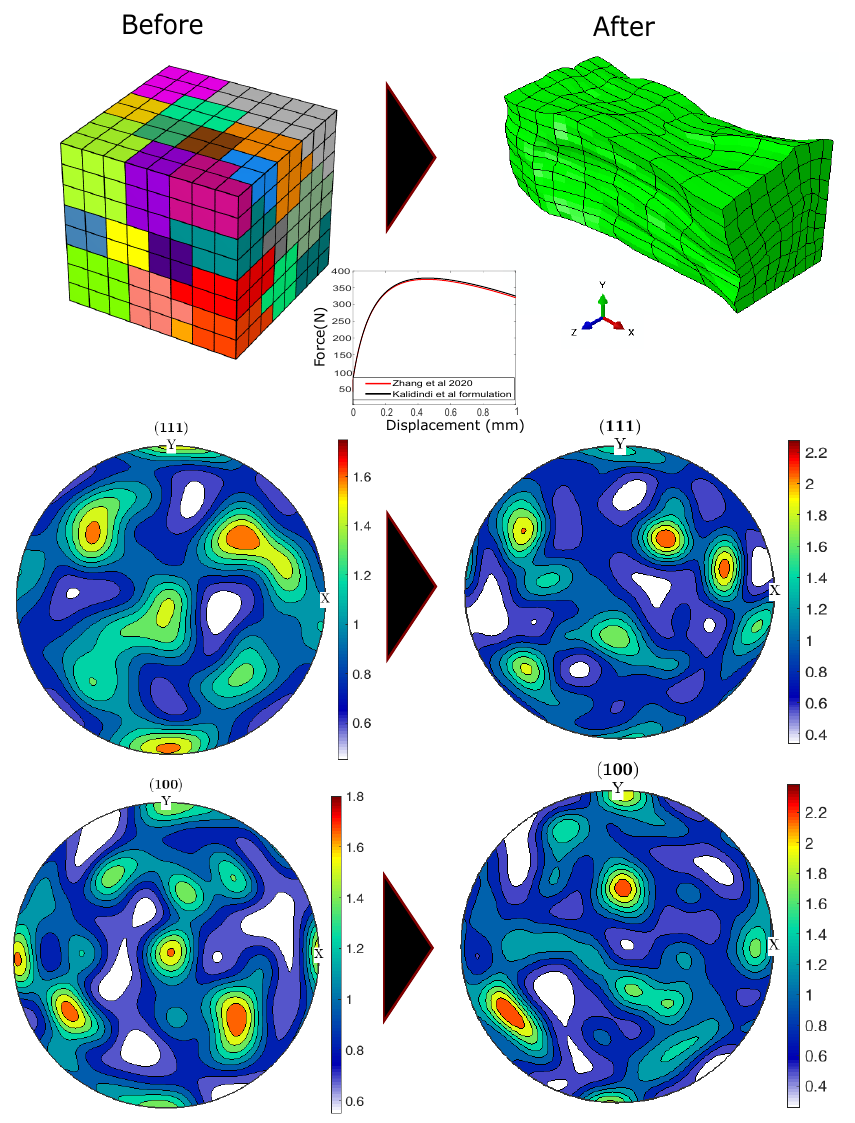
Figure 9. Evolution of texture in copper under a tensile test. Upper row contains the initial and final mesh, where colors correspond to different orientation. Middle row is shows the texture pole plots evolution for direction ( 111 ) and the lower row for direction ( 100 ) . Adapted from [75], under permission. A Matlab toolbox for pole figures, and documentation, is available in